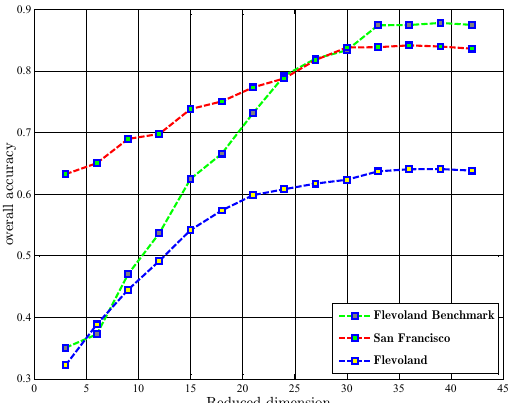
Figure 12. Overall accuracy versus reduced dimension using BSLGDA on three PolSAR data sets (with 1% training samples).